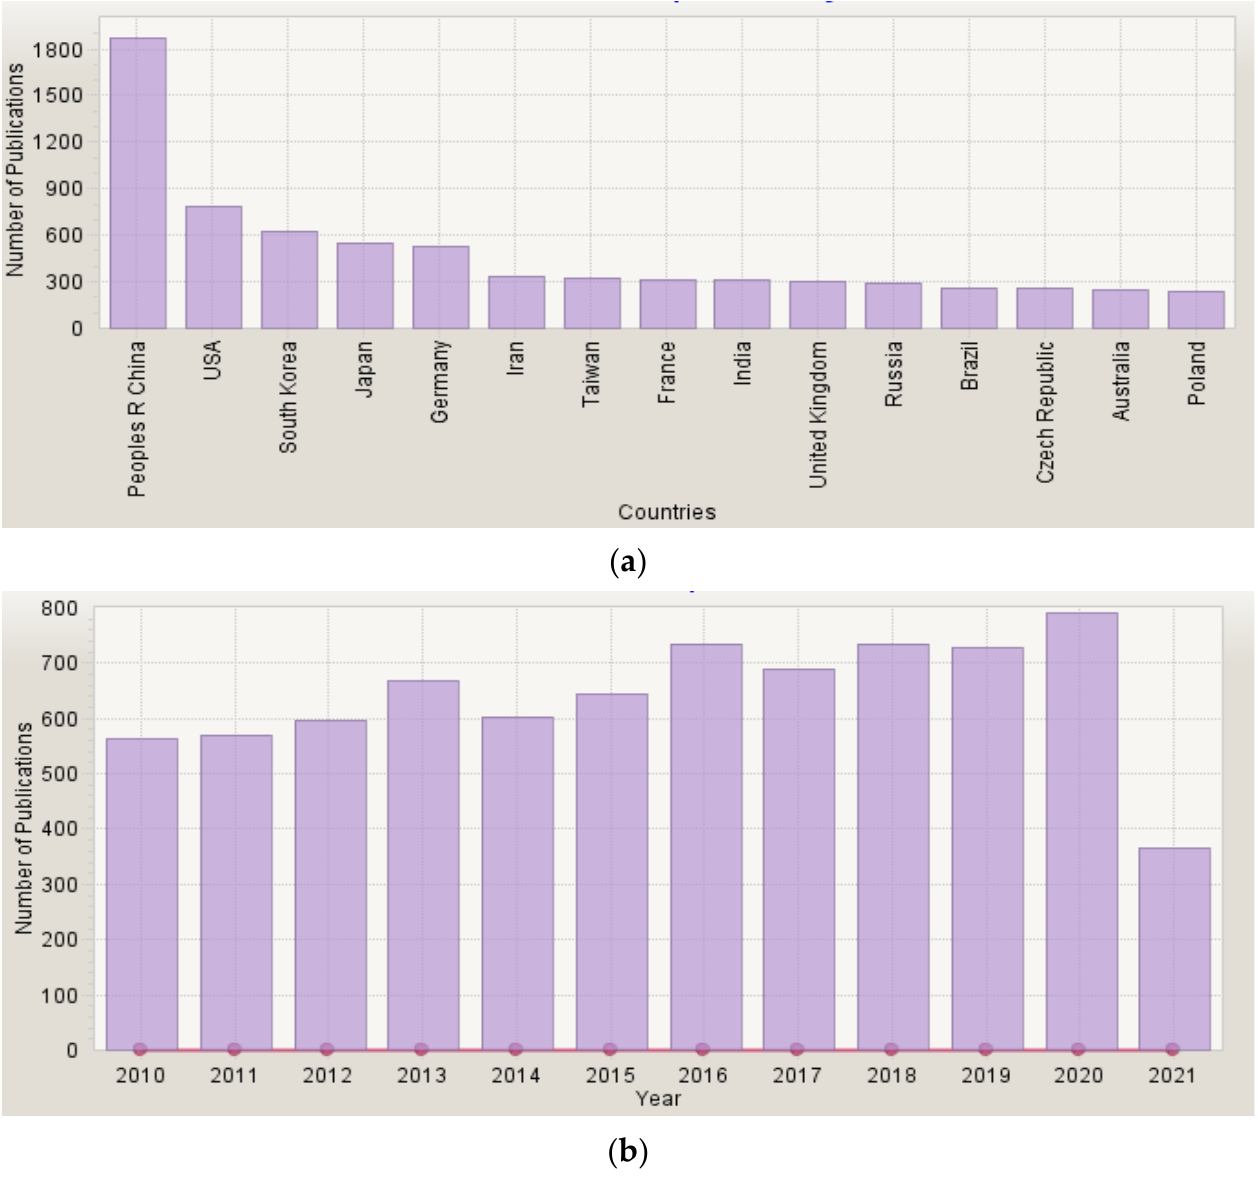
Figure 4. Quantitative research trends in plasma surface treatment literature. ( a ) Publications per country ( b ) Publications per year.